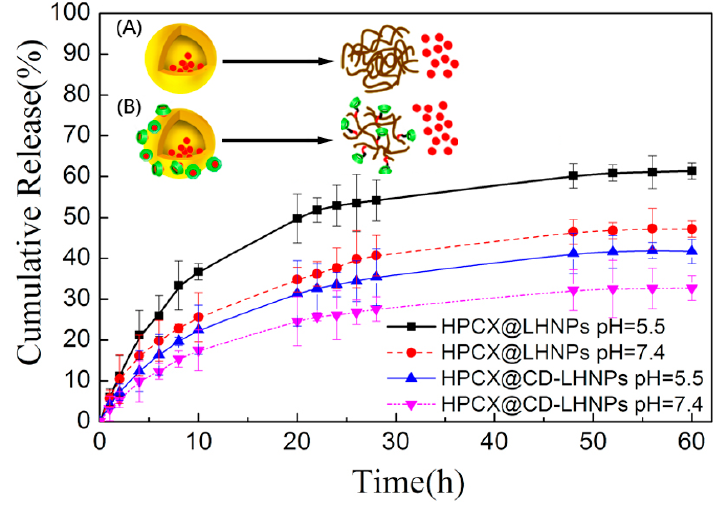
Figure 6. Release profiles of HCPT from HCPT@LHNPs and HCPT@CD-LHNPs. The inset shows a schematic illustration of drug release for ( A ) HCPT@LHNPs and ( B ) HCPT@CD-LHNPs.